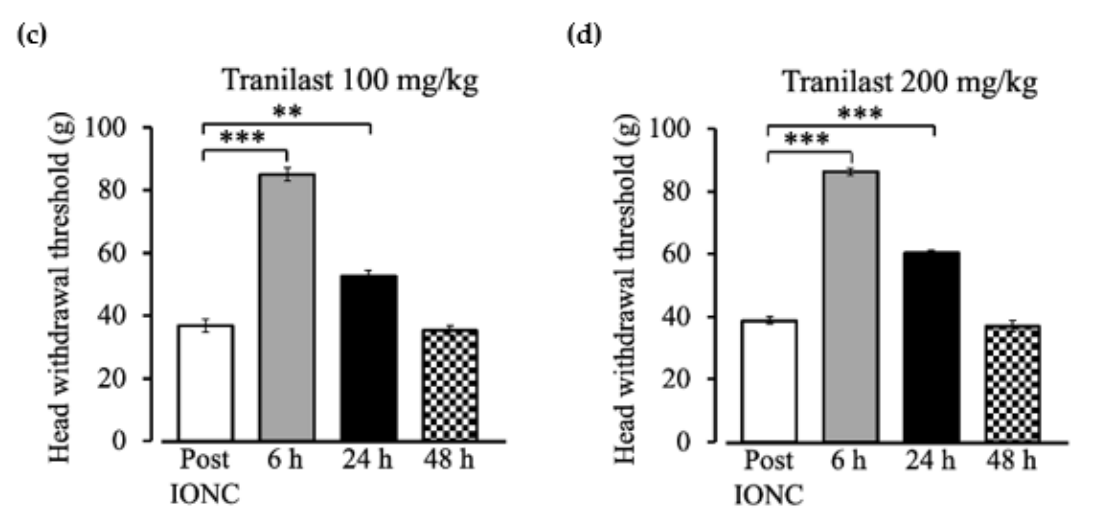
Figure 2. Head withdrawal threshold to mechanical stimuli after intraperitoneal injection of tranilast. ( a ) Tranilast 50 mg/kg showed no changes in head withdrawal threshold to mechanical stimuli. ( b ) Tranilast 75 mg/kg dosage increased the threshold to mechanical stimuli at 6 h post injection. ( c ) Tranilast 100 mg/kg and ( d ) tranilast 200 mg/kg dosages increased the threshold to mechanical stimuli at 6 and 24 h in comparison to the pain model threshold. The head withdrawal thresholds are represented as mean ± SEM. n = 6 per group. ** p < 0.01, *** p < 0.001, repeated measures analysis of variance followed by Tukey’s HSD test.